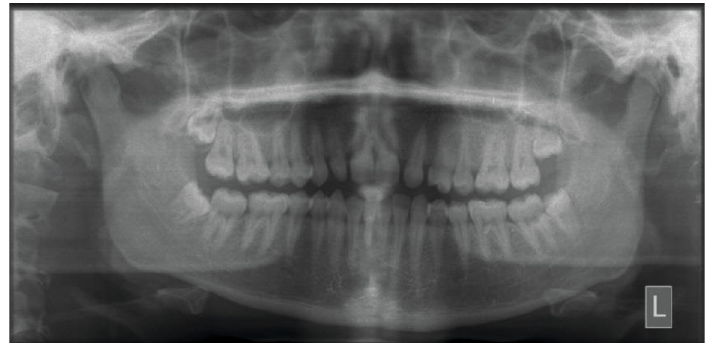
Figure 3: Pretreatment orthopantomogram.